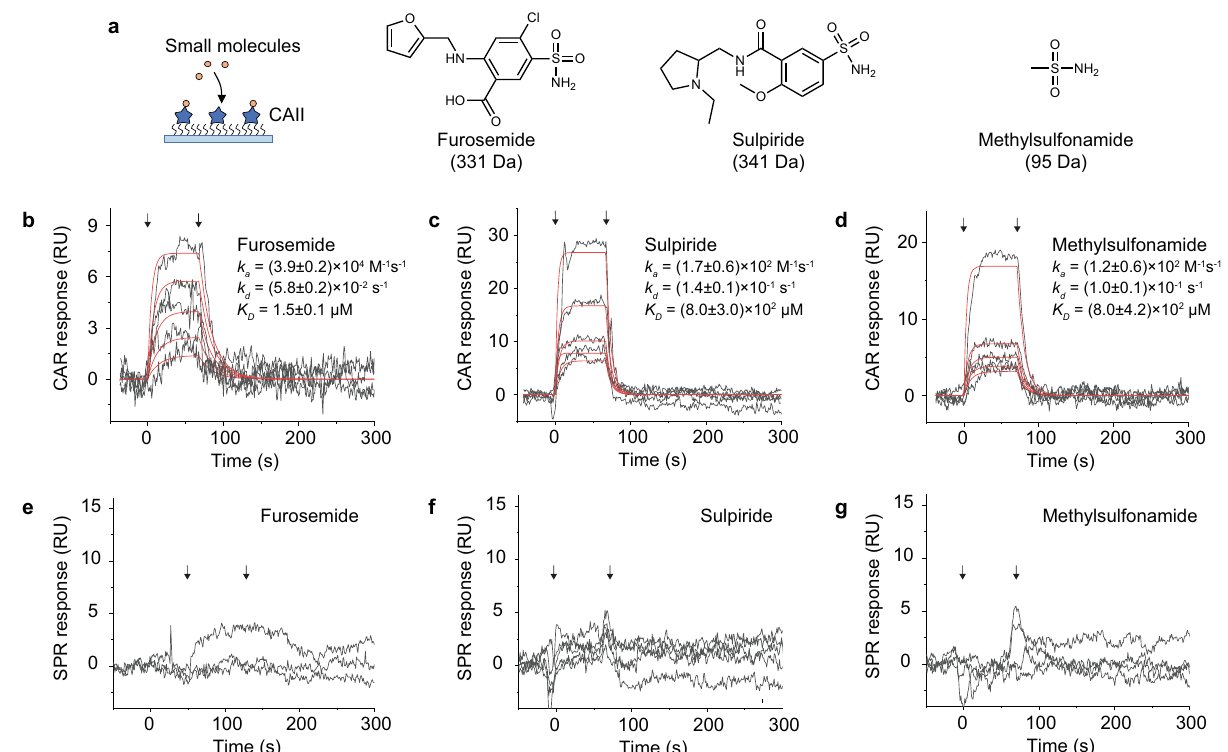
Fig. 3 Measuring the binding kinetics of small molecule ligands to carbonic anhydrase II (CAII). a CAII was immobilized on glass for CAR and gold surface for SPR measurements. Three different small molecules, furosemide (331 Da), sulpiride (341 Da), and methylsulfonamide (95 Da), were fl owed over the CAII functionalized chip. b – d CAR response curves for furosemide, sulpiride, and methylsulfonamide binding (black curves). The incident angle was set at 61.6 degrees with a sensitivity of 112 RIU − 1 . The two arrows mark the starting point of association and dissociation, respectively. The red curves are global fi ttings of the data to the fi rst-order binding kinetics. Furosemide concentrations: 234 nM, 469 nM, 938 nM, 1.88 µ M, and 3.75 µ M; Sulpiride concentrations: 62.5 µ M, 125 µ M, 250 µ M, 500 µ M, and 1.00 mM; Methylsulfonamide concentrations: 156 µ M, 312 µ M, 625 µ M, 1.25 mM, and 2.50 mM. e – g Same interactions were measured with SPR but no clear response was observed. The CAII surface coverages were 6.5% and 5.8% for the gold and the glass surfaces,